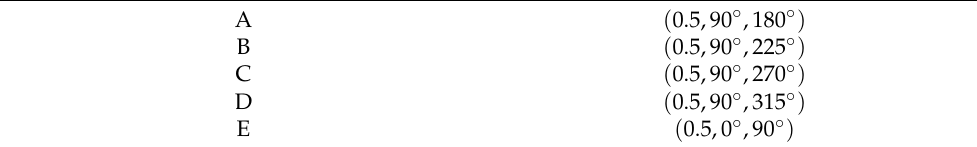
Table 5. Position of the dummy head microphone ( r , θ , φ )